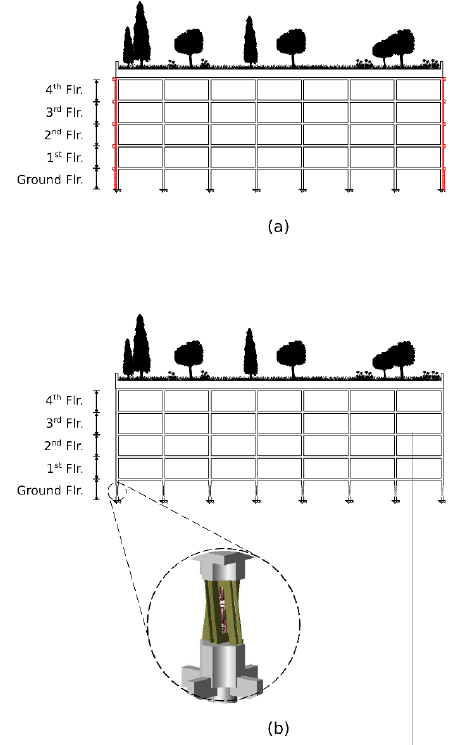
Figure 2. Vertical building section (A-A) of ( a ) concrete wall strengthening with deep green roof (Cases 1 and 2) and ( b ) SIC retrofitted structure with a deep green roof (Cases 3 and 4).